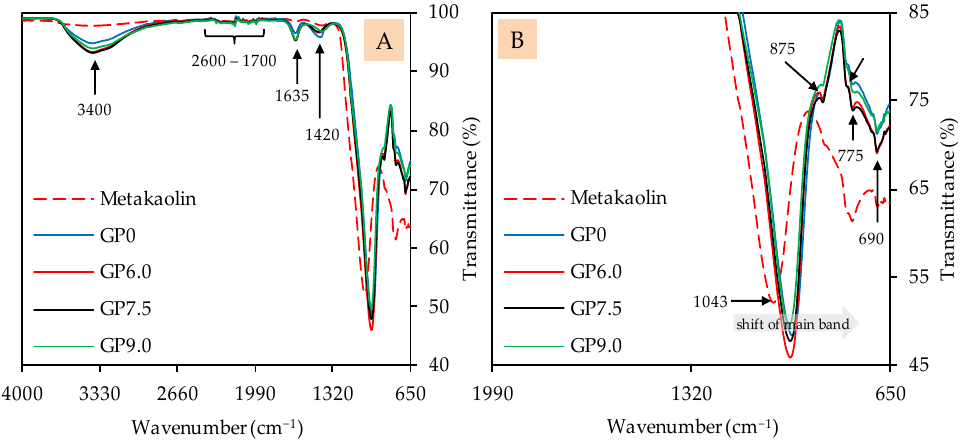
Figure 7. FTIR spectra of metakaolin and geopolymers after 28 days of curing. Full ( A ) and partial spectra ( B ).